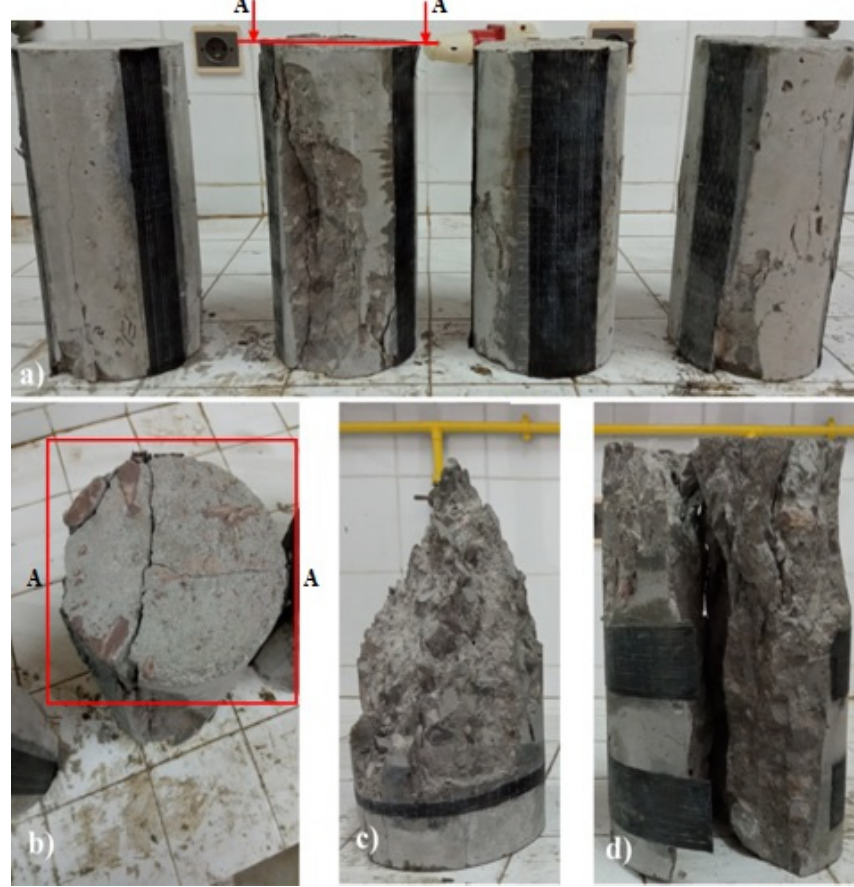
Figure 8. Failure modes of plain concrete cylinders after compression tests: ( a ) failure by splitting; ( b ) cross-sectional area of first failure mode; ( c ) shear (cone); and ( d ) brutal failure of concrete.